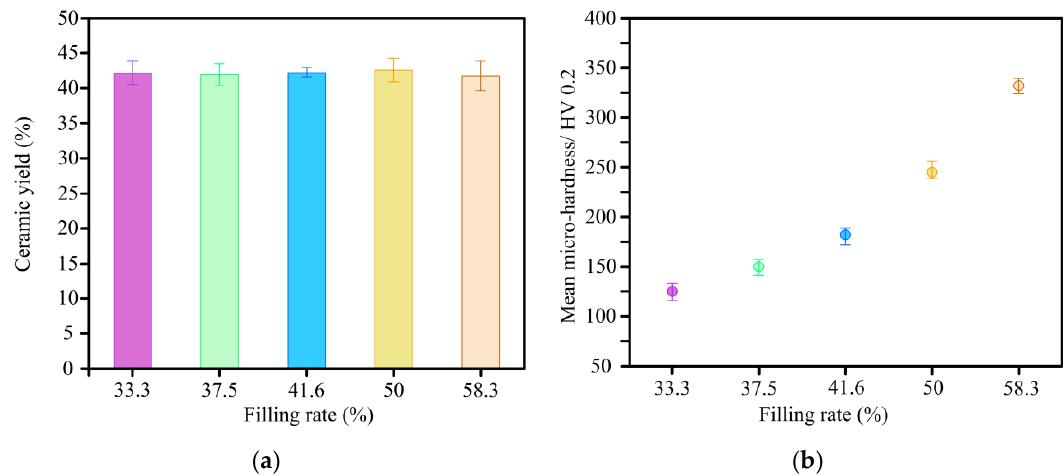
Figure 12. Experimental results of ( a ) ceramic yield and ( b ) micro-hardness of C WCMs with different filling rate of wood powder, under a constant resin concentration of 30%.